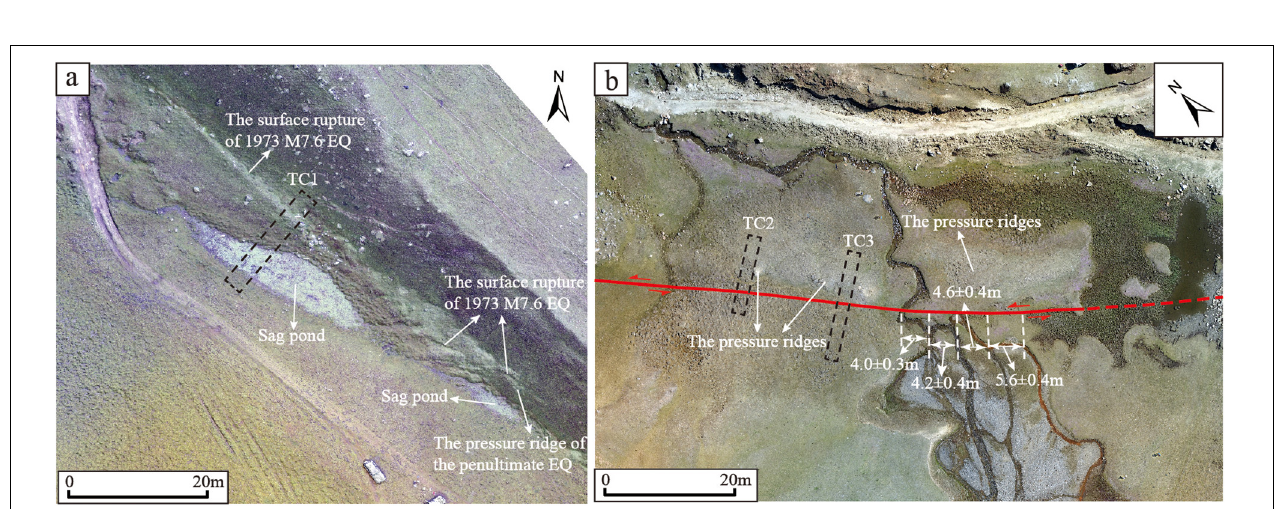
FIGURE 3 | The surface rupture of the 1973 M7.6 earthquake and the tectonic landforms at the trench sites: (a) site 1 and (b) site 2 (as shown in Figure 2 ). The black dashed rectangles mark the locations of the trenches.